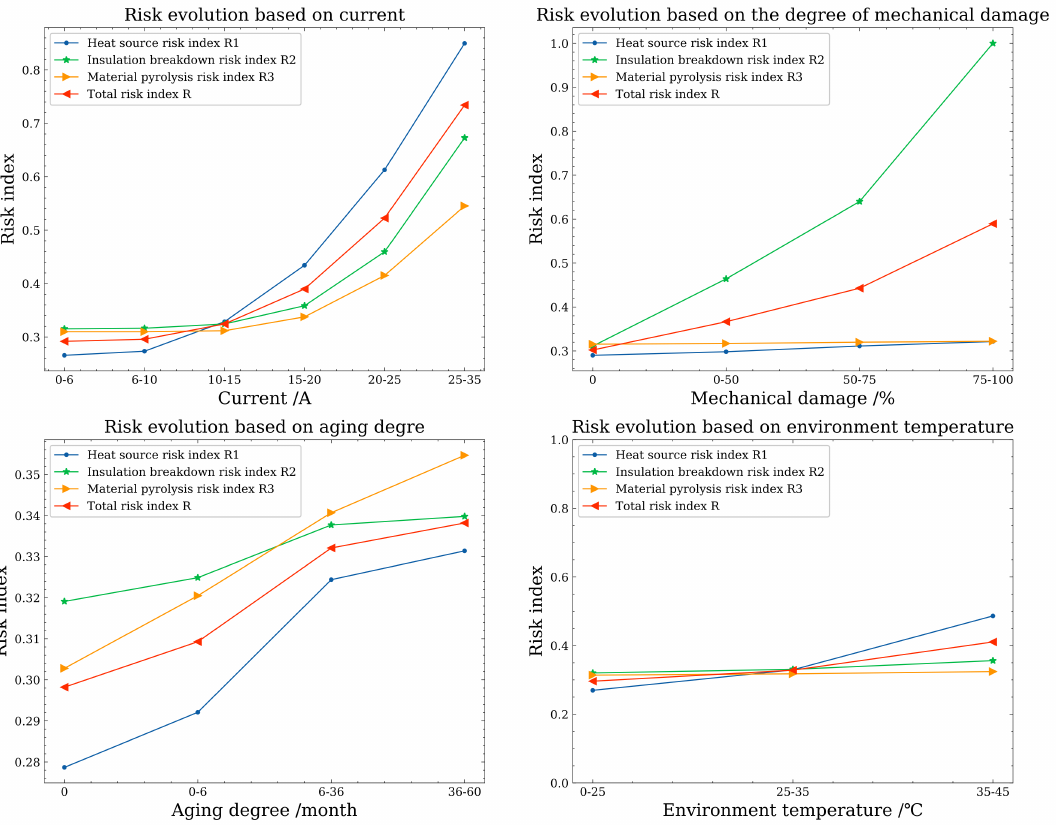
Figure 8. Risk evolution.